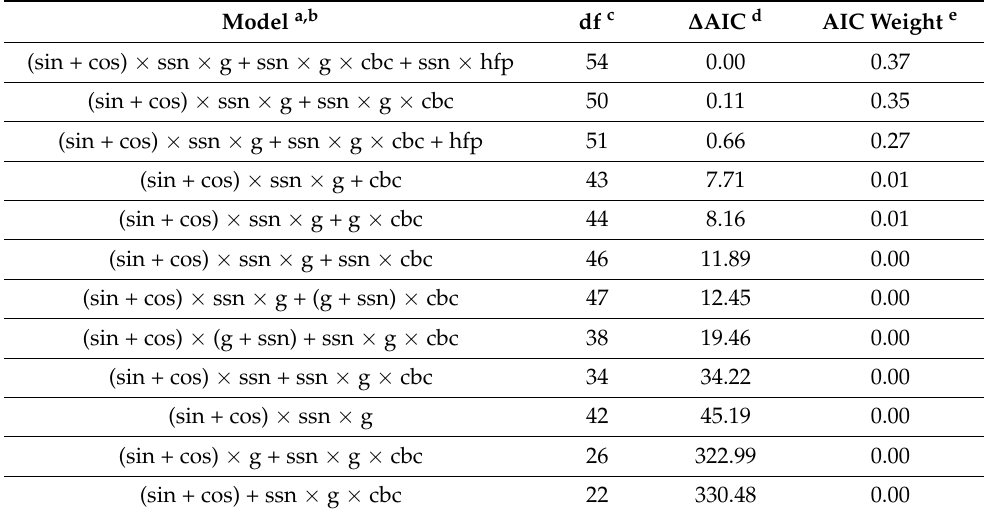
Table 2. Generalized linear mixed models of maximum hourly movement distances of American White Pelicans.